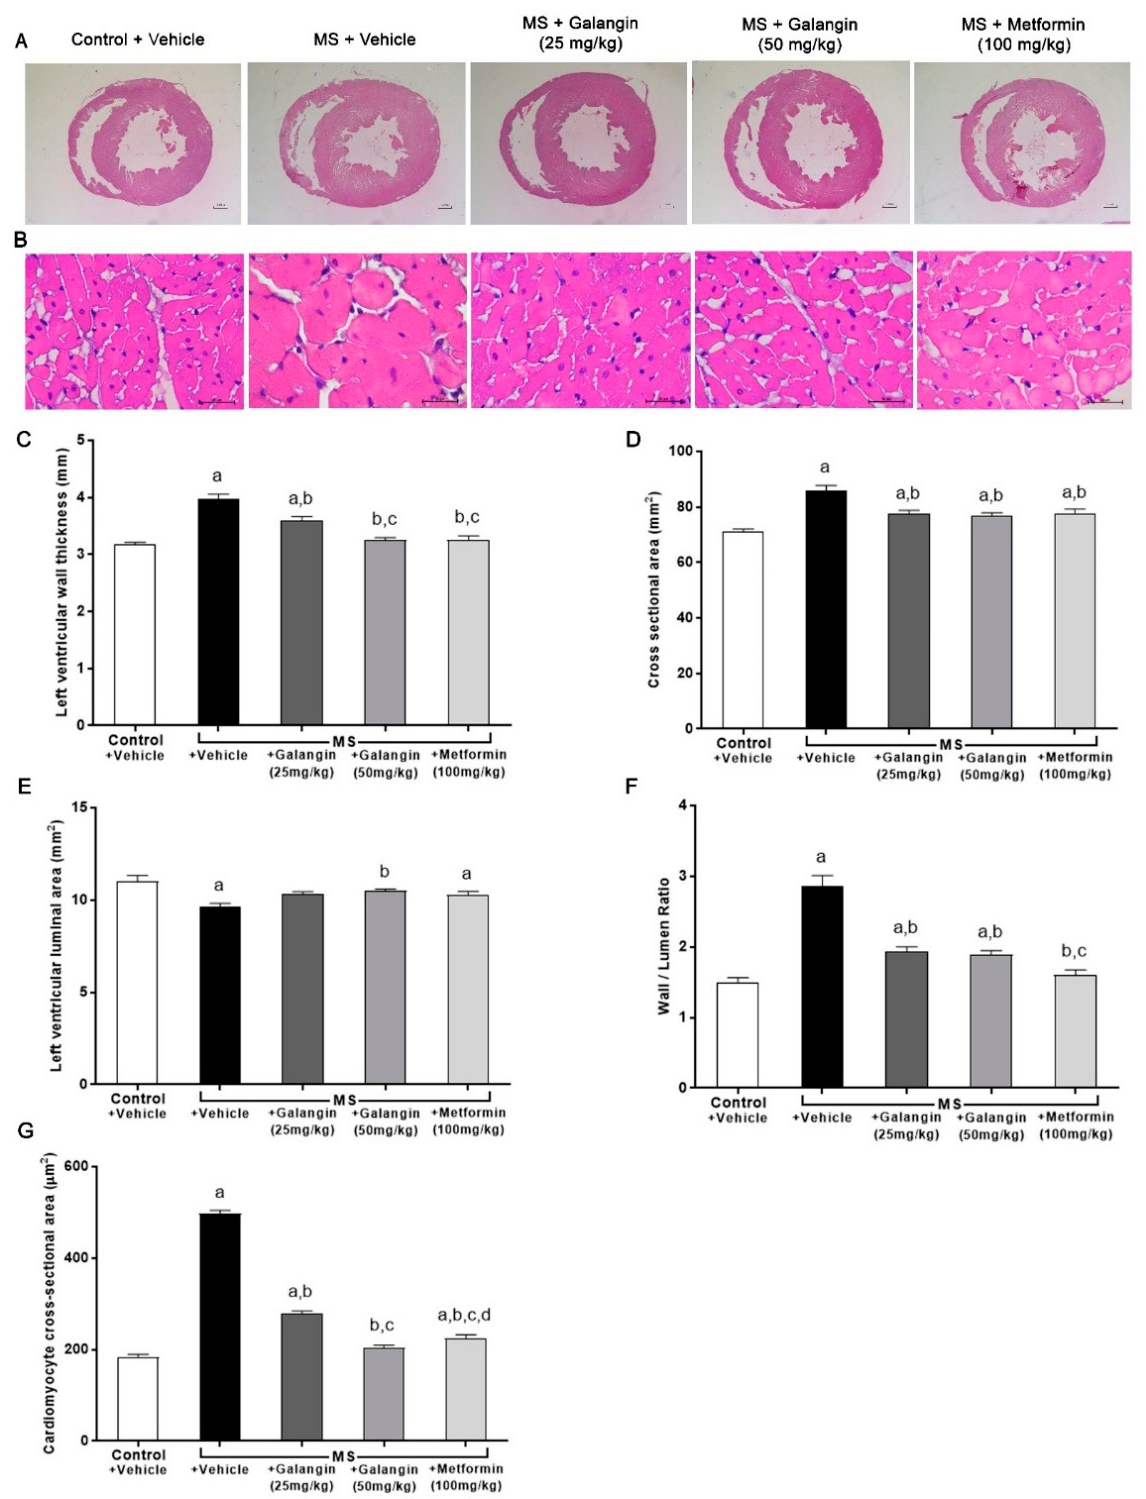
Figure 4. Morphology of heart. ( A ) Representative photographs of heart sections stained with H&E (magnification ×10) (scale bar = 5 mm). ( B ) Representative cross-sections of cardiomyocytes stained with H&E (magnification ×400) (scale bar = 20 µm). ( C ) Effects of galangin and metformin treatments on left ventricular wall thickness, ( D ) cross-sectional areas, ( E ) left ventricular luminal areas, ( F ) wall/lumen ratio, and ( G ) cardiomyocyte area. Results are shown as the mean ± S.E.M. ( n = 8). a p < 0.05 vs. the control group, b p < 0.05 vs. the MS group, c p < 0.05 vs. the MS + galangin (25 mg/kg) group, and d p < 0.05 vs. the MS + galangin (50 mg/kg)